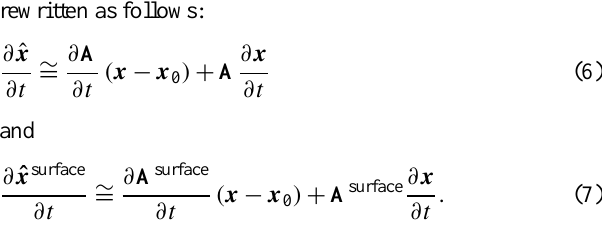
Figure 3. Mean MOPITT averaging kernel for surface CO, a priori, and retrieved CO profiles 2 Fig. 3. Mean MOPITT averaging kernel for surface CO, a priori, over the grid cell defined by 30°E, 45°E, 110°N, and 120°N over East China on October 3 and retrieved CO profiles over the grid cell defined by 30 ◦ E, 45 ◦ E, 2002. The relative difference between retrieved CO with a priori profiles is shown to estimate 4 110 ◦ N, and 120 ◦ N over East China on October 2002. The relative the difference of true with a priori states ( x − x 0 ). The retrieved CO at the surface is about 5 difference between retrieved CO with a priori profiles is shown to estimate the difference of true with a priori states ( x − x 0 ). The 52% higher than the a priori CO mixing ratio. 6 retrieved CO at the surface is about 52% higher than the a priori CO mixing